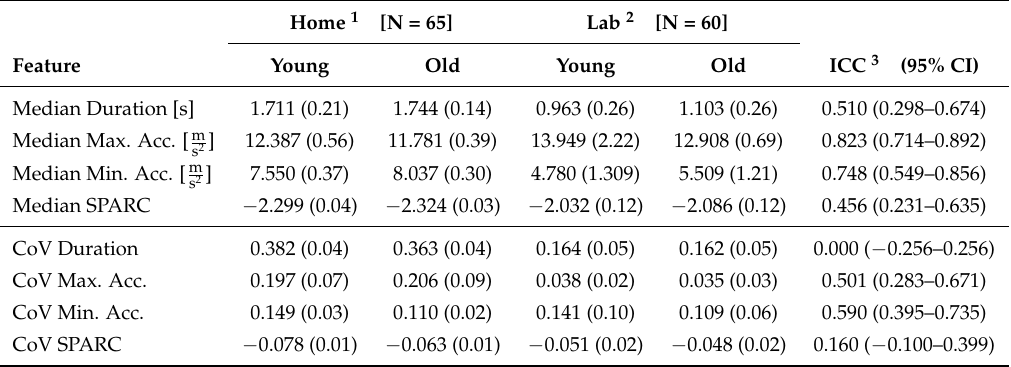
Table 3. Mean (SD) of features extracted from STS transfers from the two age groups (young and old) of healthy subjects, and an assessment of test-retest reliability based on the two in lab visits. Med. is